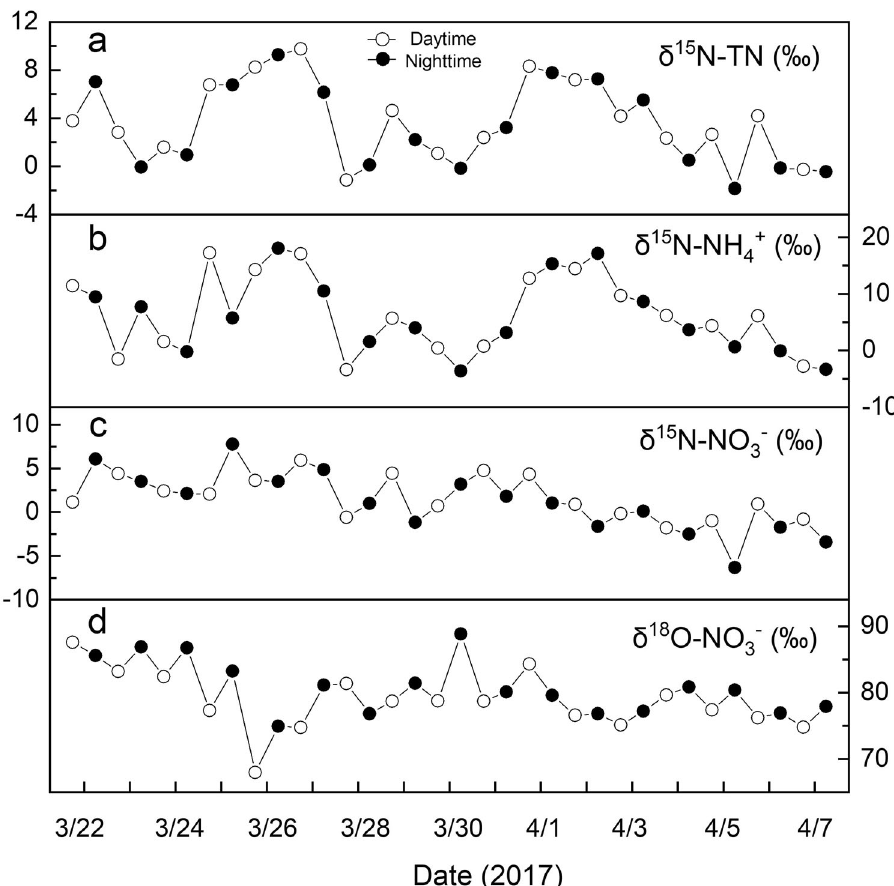
Fig. 2 Results of stable isotope analyses. Stable nitrogen isotopic compositions of a total nitrogen (TN) and b NH 4 + , and dual isotopes ( c δ 15 N and d δ 18 O) of NO 3 − in daytime and nighttime total suspended particles over Mt. Tai in spring